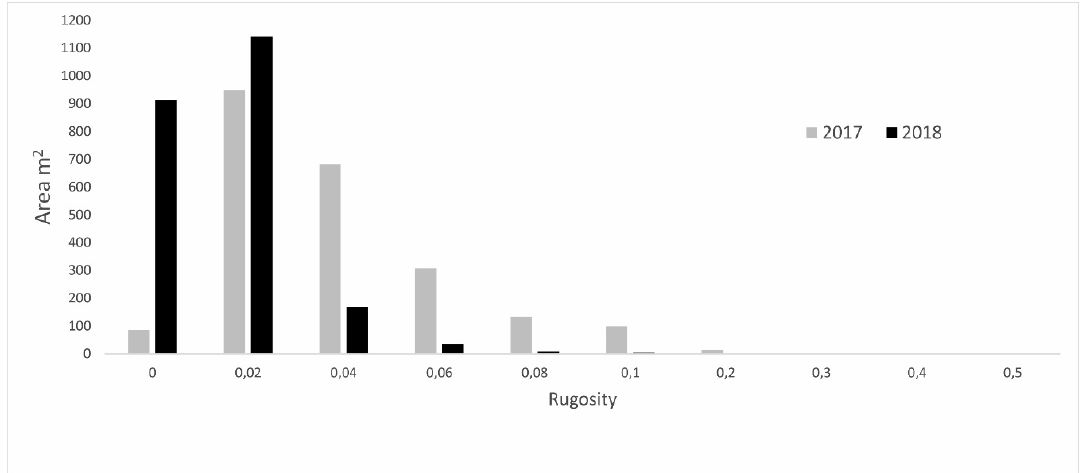
Figure 7. The histogram describes the temporal change (from 2017 to 2018) in the extent of areas with the same rugosity index in the selected portion of Area 4 (Figure 6).